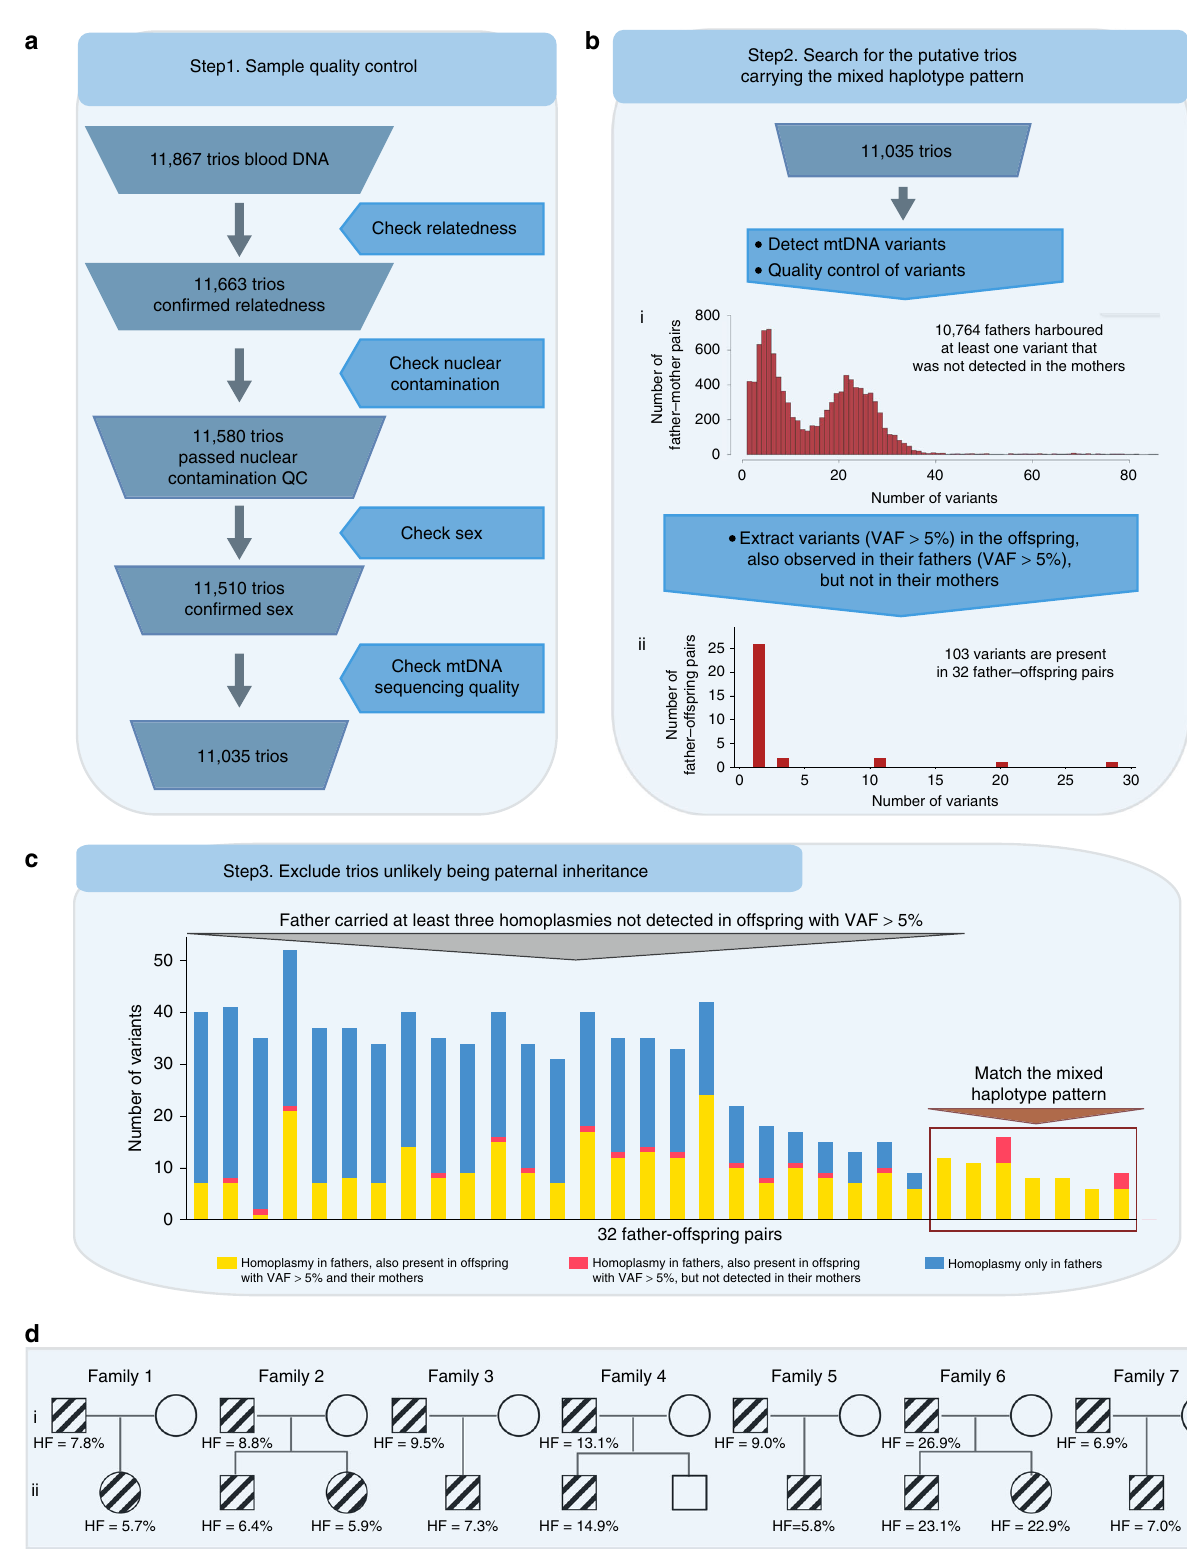
Fig. 1 Bioinformatic pipeline to detect the mixed haplotypes from 11,867 trios. a Sample quality control. b Search for the putative trios carrying the mixed haplotype pattern. I. Distribution of the informative trios where at least one variant (variant allele fraction (VAF)>5%) is detected in the father, but not in the mother. II. Distribution of trios where at least one variant was shared in the fathers and their offspring. c Number of homoplasmic variants in 32 fathers. Yellow bars represent fathers ’ homoplasmic variants also observed in the mothers and their offspring; pink bars represent the homoplasmic variants also observed in their offspring, but not detected in the mothers. Blue bars represent homoplasmic variants only observed in the fathers which are not detected in either the mothers or their offspring. d Pedigrees of the seven families showing mixed haplotypes. The symbols with lines represent the individuals carrying the mixed